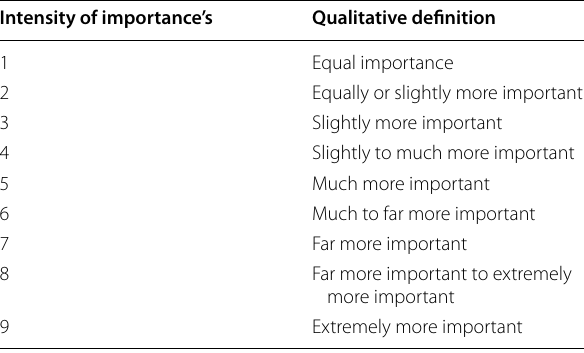
Table 3 Fundament scale used in Pair-wise comparison